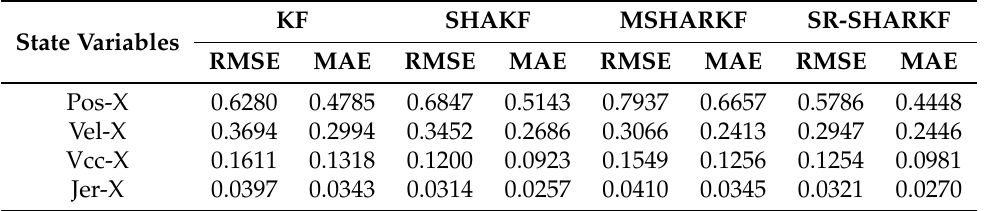
Figure 7. Dynamic parameter error in the X-axis direction. ( a ) Position error. ( b ) Velocity error. ( c ) Acceleration error. ( d ) Jerk error. Table 3. Dynamic parameter error evaluation in the X-Axis